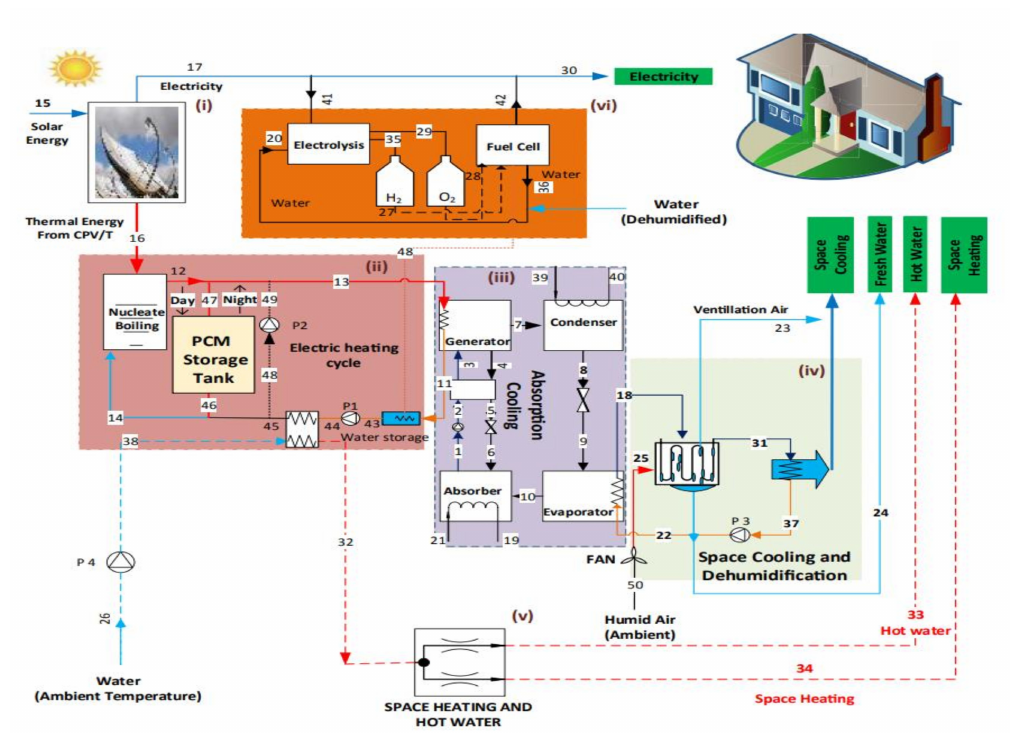
Figure 32. Schematic of the multigeneration CPVT system (reprinted from [148], with permission from